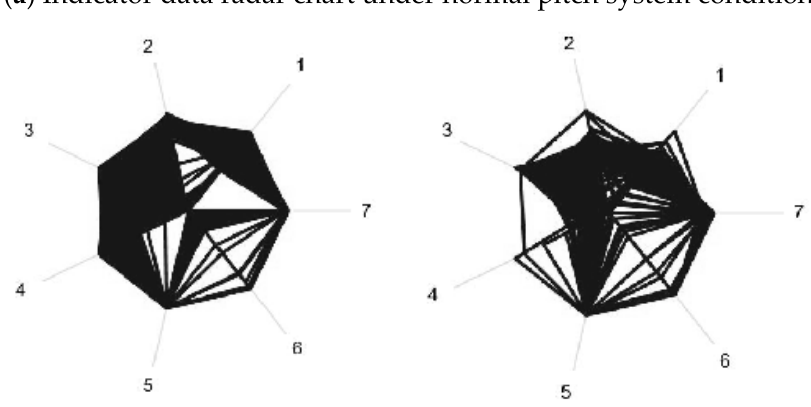
Figure 4. Indicator data radar charts grayscale processing.